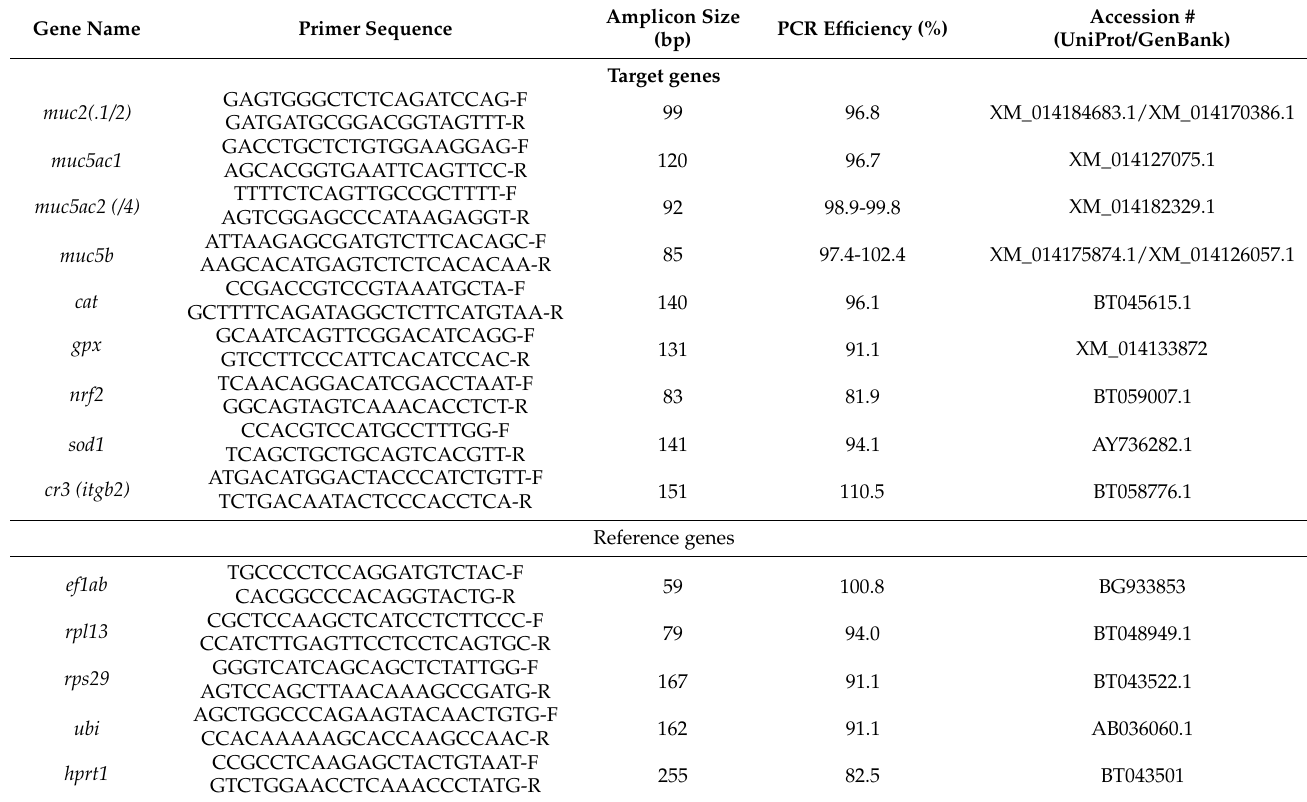
Table 6. Primer sequences, amplicon size, PCR efficiency and accession numbers for the target genes and reference genes involved in this